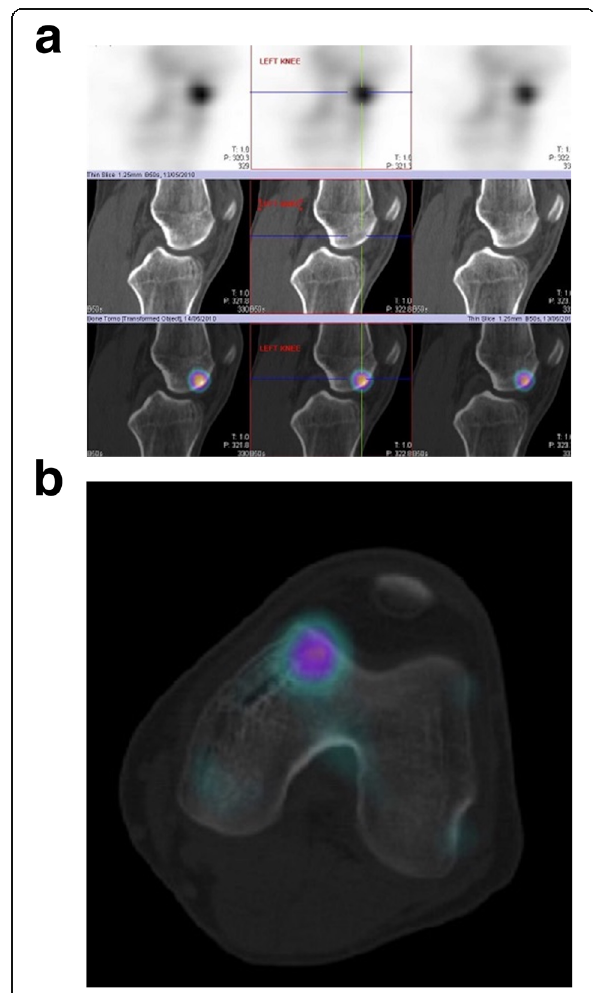
Fig. 3 a Sagittal SPECT-CT scan slices of the same patient demonstrating obvious abnormality with focally increased tracer activity pertaining to the sub-chondral aspect of the medial femoral condyle. b Tranaxial SPECT-CT slice of the left knee highlighting the lesion on the medial femoral